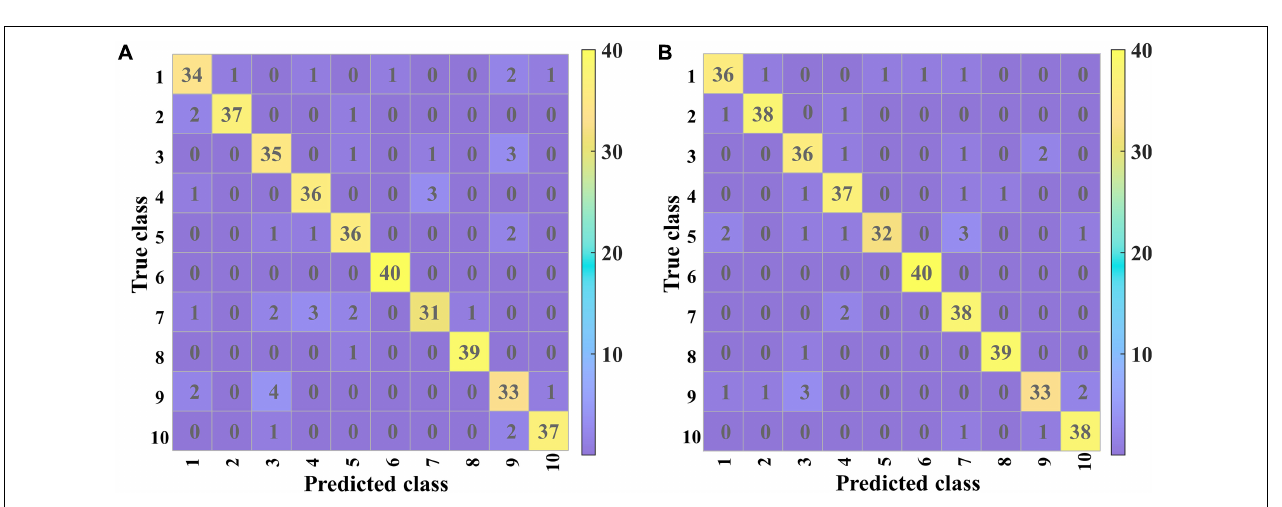
FIGURE 7 | Connected saliency maps for spectral matrix of soybean seeds in prediction set from ten varieties based on 2D-PCSA-ResNet. The two spectra at the bottom are same and are the average spectra from prediction set.